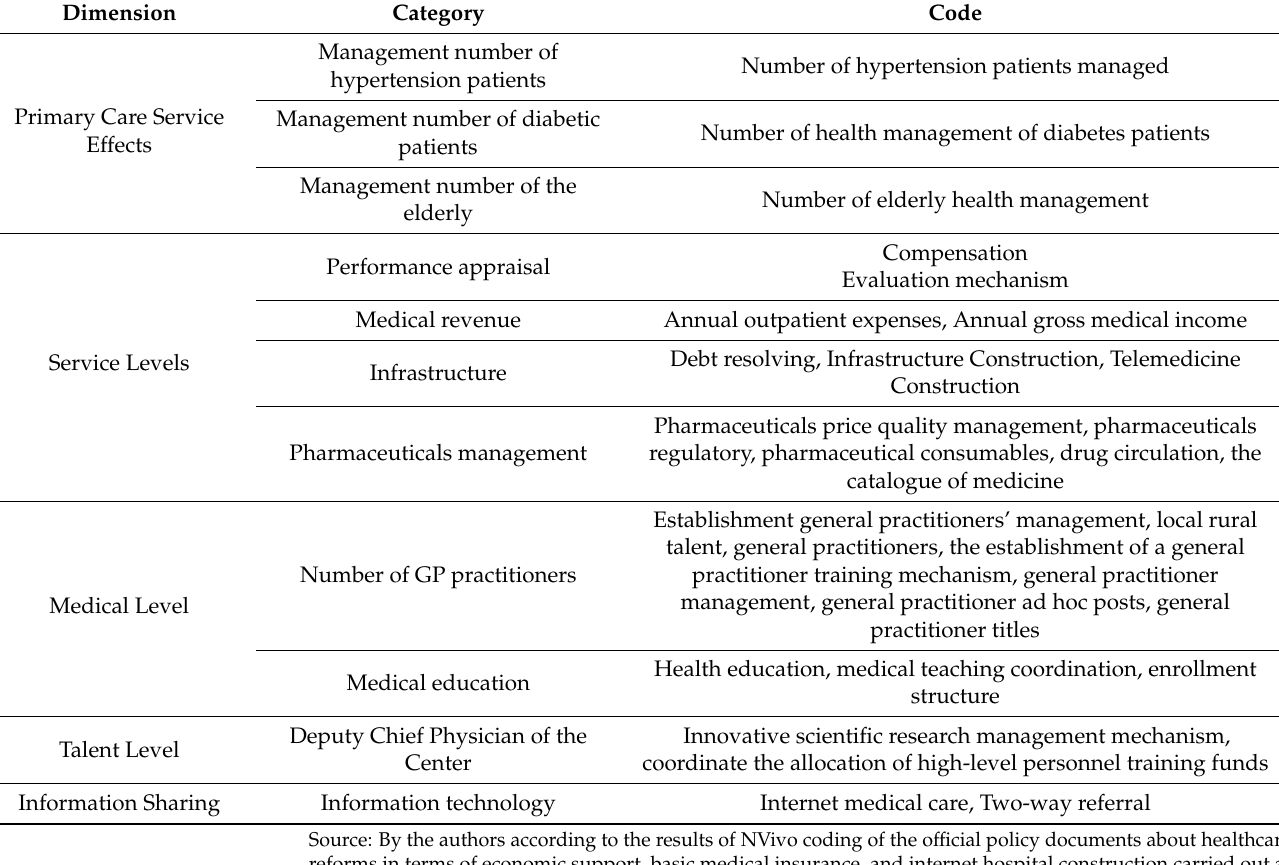
Table 1. Selective or theoretical coding results.